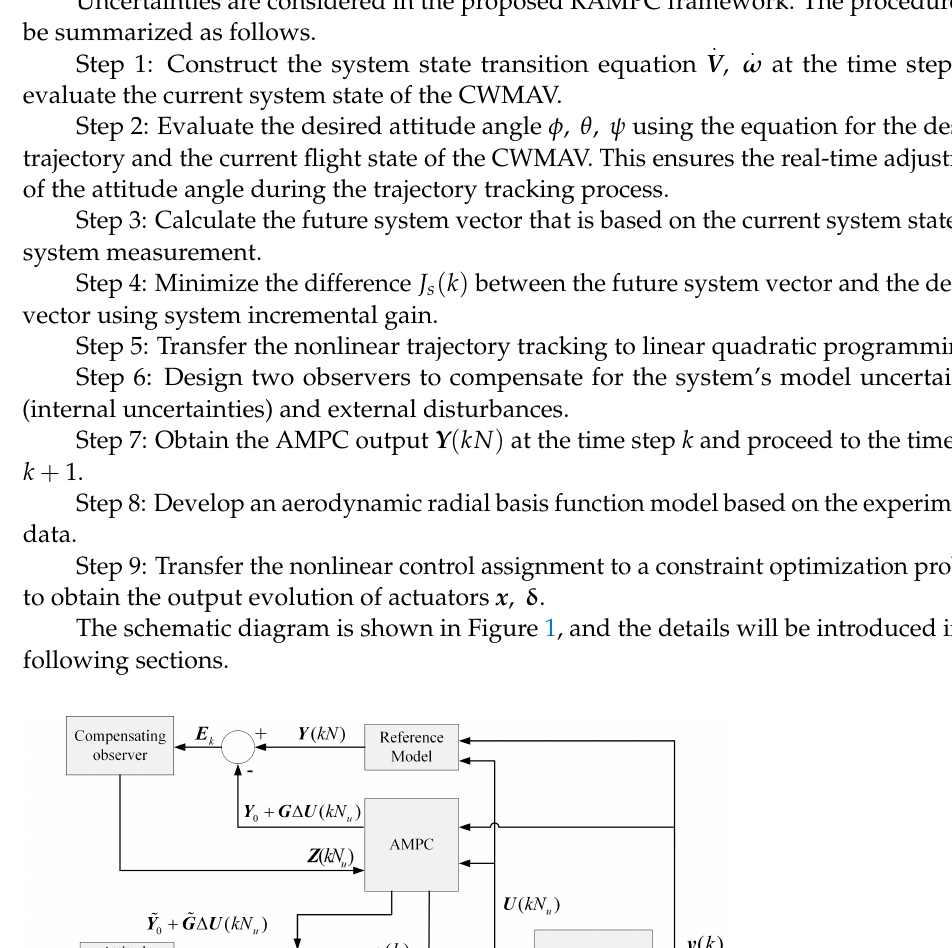
( b ) Figure 2. Schematic diagram of the coordinate systems. 2.1.2. Nonlinear Dynamics System of CWMAV According to the law of conservation of momentum, the force